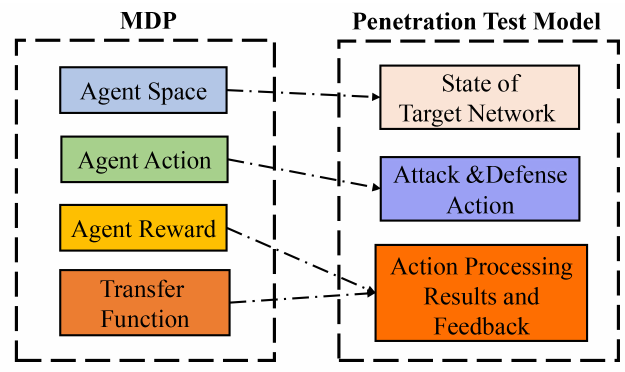
Figure 8. Relationship between MDP and penetration test